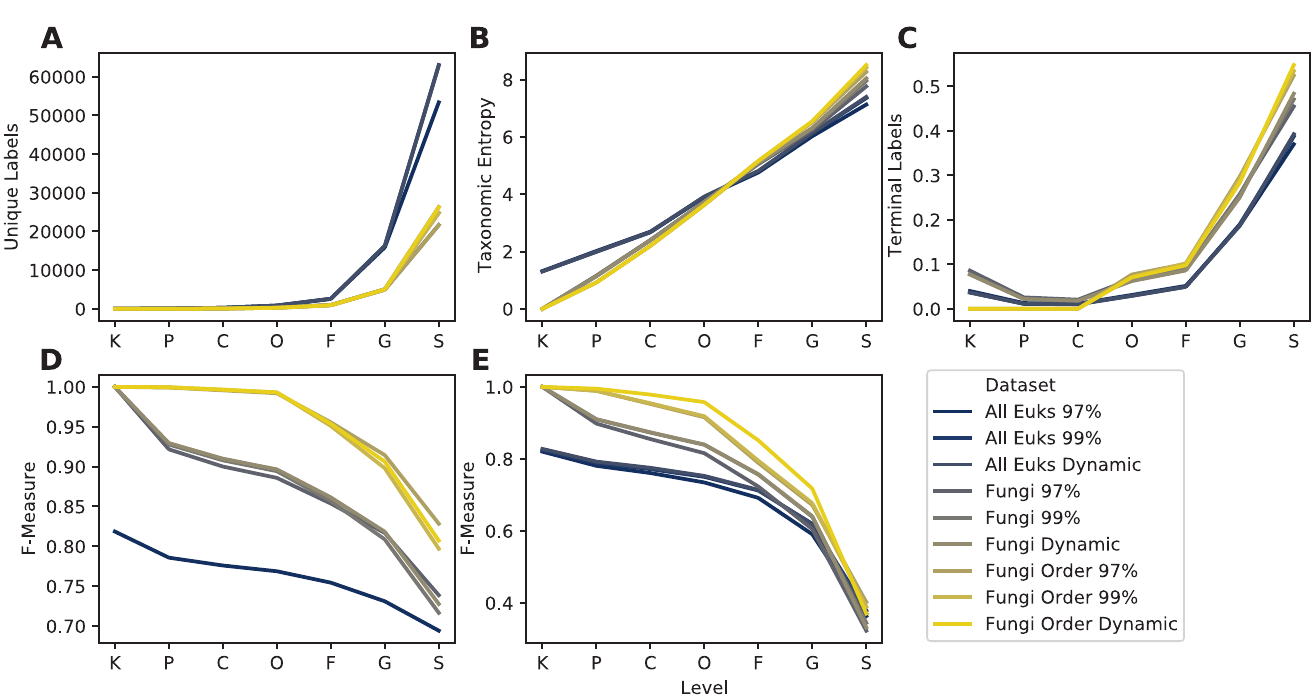
Fig 9. Taxonomic information (A–C) and classification accuracy (D–E) of UNITE ITS domain database with different filtering and clustering settings. Filtered versions include the "all Eukaryotes" 2020.04.02 release version containing all Eukaryotes ("All Euks"), filtered to contain only Fungi, and filtered to contain only Fungi with at least order-level taxonomic annotation ("Fungi Order"). Cluster levels indicate which UNITE release version was used: sequences clustered at 97% similarity, 99% similarity, or the UNITE "dynamic" species hypothesis threshold. Subpanels show taxonomic/classification characteristics at each taxonomic level: A, Number of unique taxonomic labels; B, Taxonomic entropy; C, proportion of taxa that terminate at that level; D, optimal classification accuracy (as F-Measure) without cross-validation (simulating best possible classification accuracy when the true label is known but classification accuracy may be confounded by other similar hits in the database); E, classification accuracy (F-Measure) with cross-validation (simulating realistic classification tasks when the correct label is unknown). Rank labels on x-axis: K = kingdom, P = phylum, C = class, O = order, F = family, G = genus, S = species. See Materials and Methods for more details on how these databases were created and